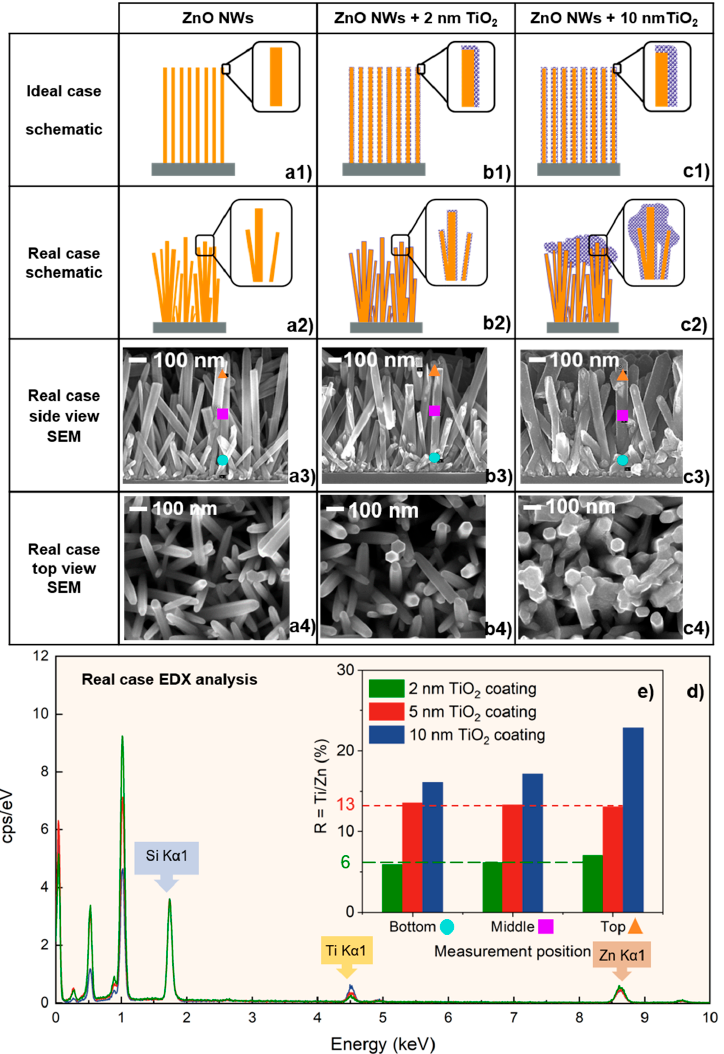
Figure 1. Characterization of TiO 2 -coated ZnO NWs. ( a1 , b1 , c1 ) Schematic descriptions of the ZnO NWs with TiO 2 coating in ideal cases with different thickness values and ( a2 , b2 , c2 ) more realistic schematic descriptions. ( a3 , b3 , c3 ) Cross-section SEM images showing the morphologies as well as the 3 different measurement positions from bottom to top. ( a4 , b4 , c4 ) Top-view SEM images. ( d ) EDX spectra of the top position recorded on the 2 nm, 5 nm, and 10 nm TiO 2 -coated ZnO NW samples. ( e ) The histogram of the Ti/Zn atomic ratio for different positions, bottom, middle, and top, on each of the 3 samples.